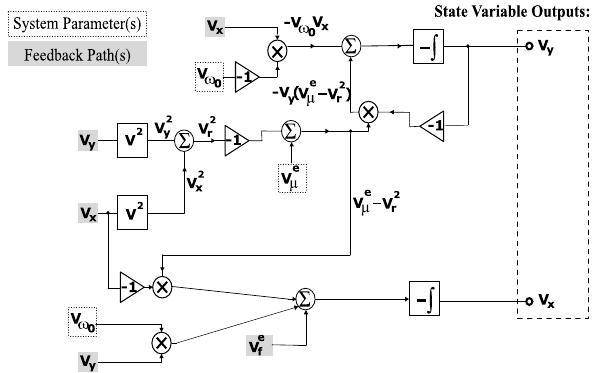
Figure 5. A simplified schematic for the Hopf PRC, with states V x and V y . V e µ = V µ ( 1 + V u V m ) and = A ( 1 + V u V m ) sin (� t + φ) V e f